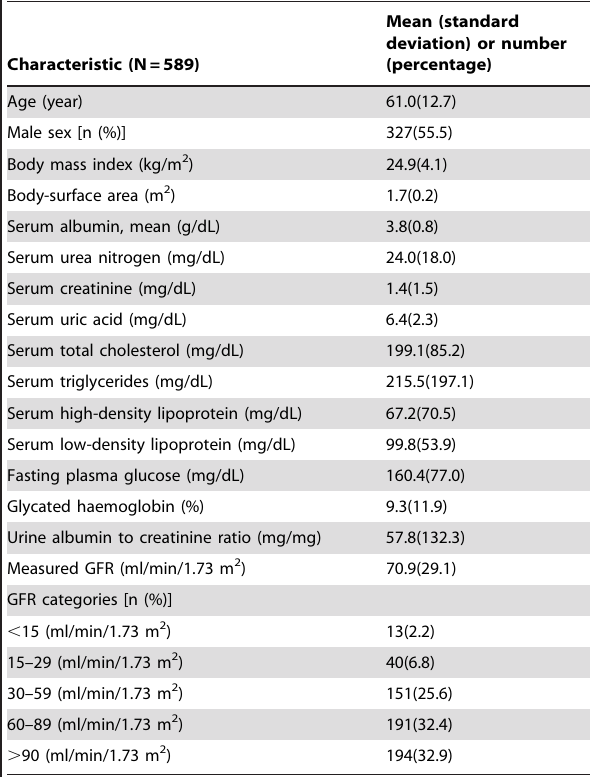
Table 4. Patient’s characteristic.